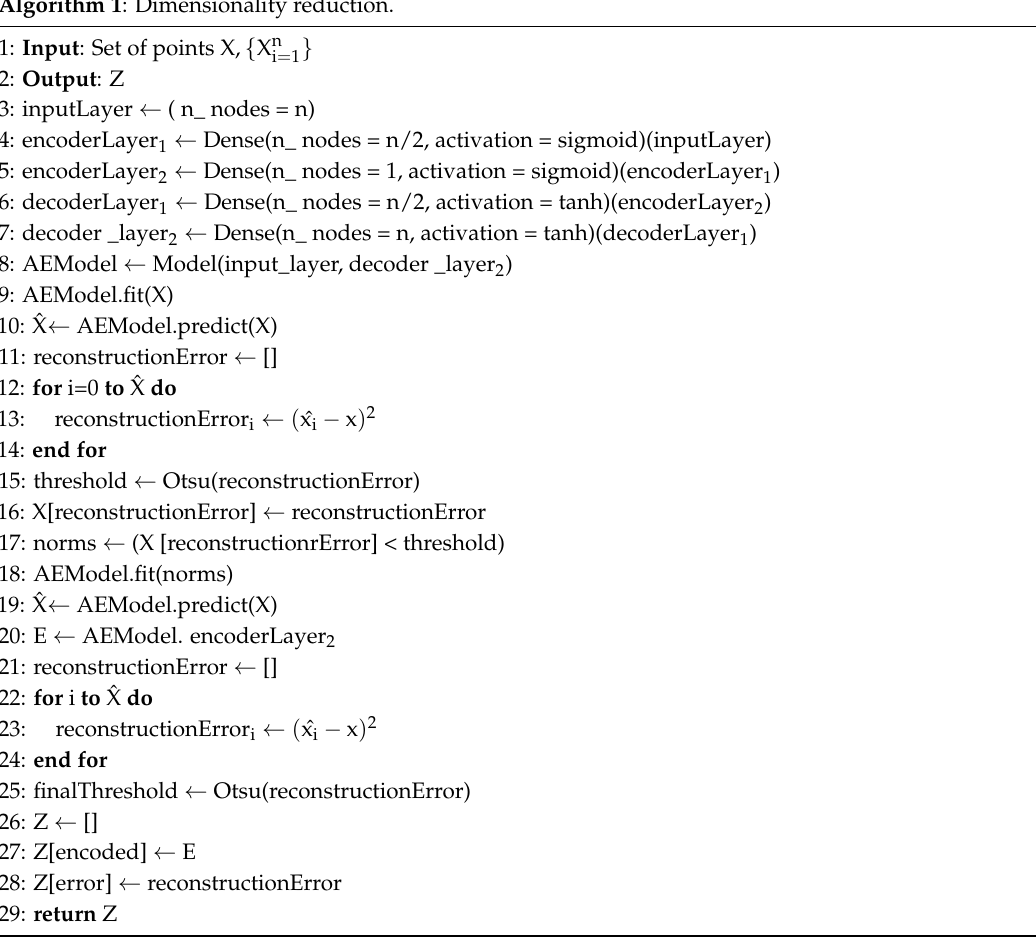
Algorithm 1 : Dimensionality